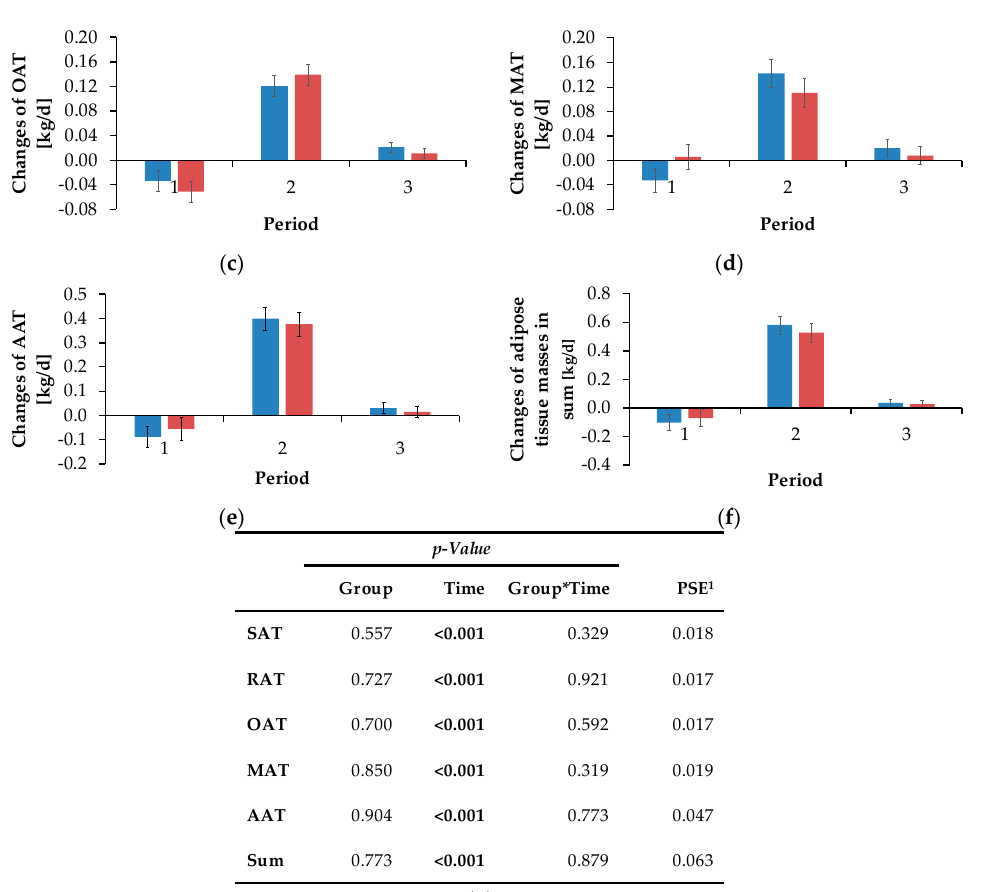
Figure 8. Changes in the ( a ) subcutaneous (SAT), ( b ) retroperitoneal (RAT), ( c ) omental (OAT), ( d ) mesenteric (MAT), ( e ) abdominal (AAT) adipose tissue masses and changes in masses of (f) SAT, RAT, OAT and MAT in sum of cows fed a non-supplemented (CON) or an L-carnitine-supplemented diet (25 g/d from 6 weeks ap up to week 15 pp , CAR), while positive values indicate a reduction and negative values indicate a gain of particular masses. ( g ) Data statistics. Period 1 = day 42 ap until day 3 pp , period 2 = day 3 pp until day 42 pp , period 3 = day 42 pp until day 100 pp . Data are given as LS-means ± standard error. 1 pooled standard error.